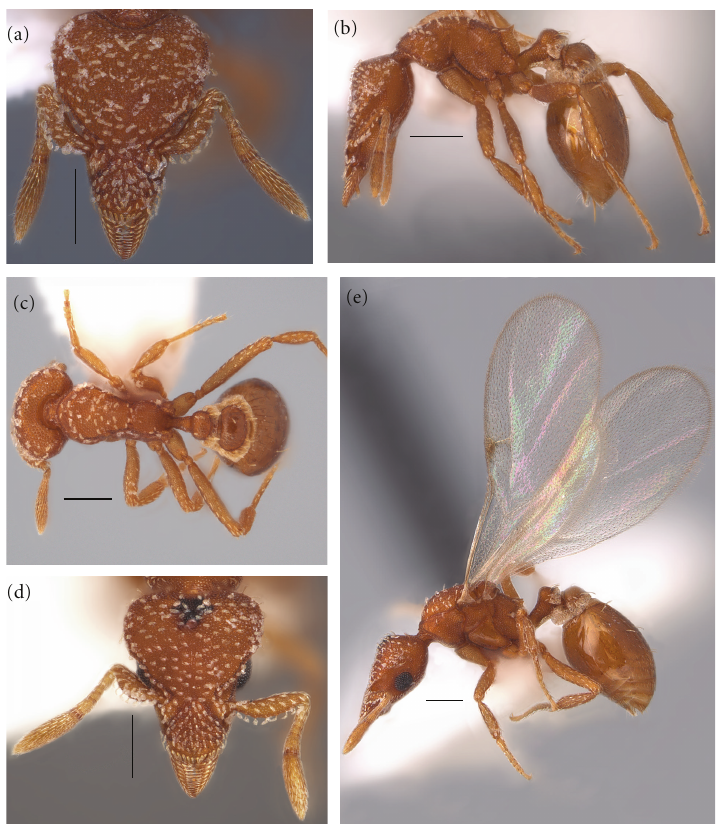
Figure 1: Pyramica epinotalis : (a) full face view of worker, (b) lateral view of worker, (c) dorsal view of worker, (d) full face view of female, and (e) lateral view of alate female. Scale bar equals 200 µ m.